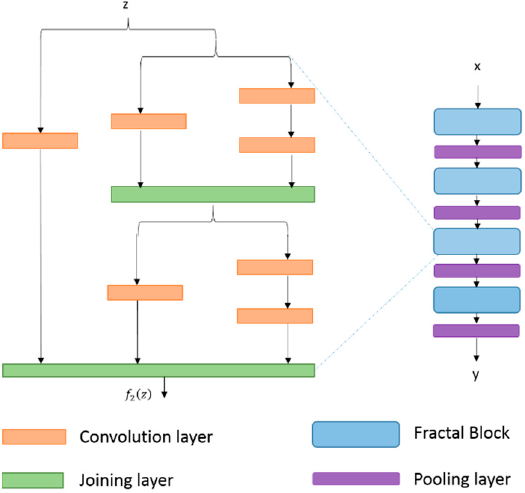
Figure 19. The detailed FractalNet module on the left and FractalNet on the right.